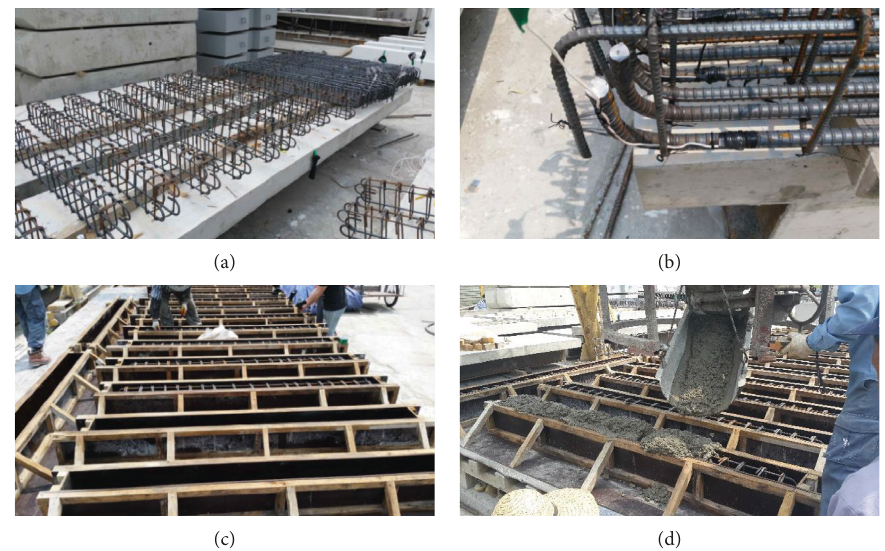
Figure 5: Beam manufacturing process: (a) assembly of reinforcing bar cage, (b) wire for corrosion of reinforcing bar, (c) installation of reinforcing bar cage, and (d) placement of